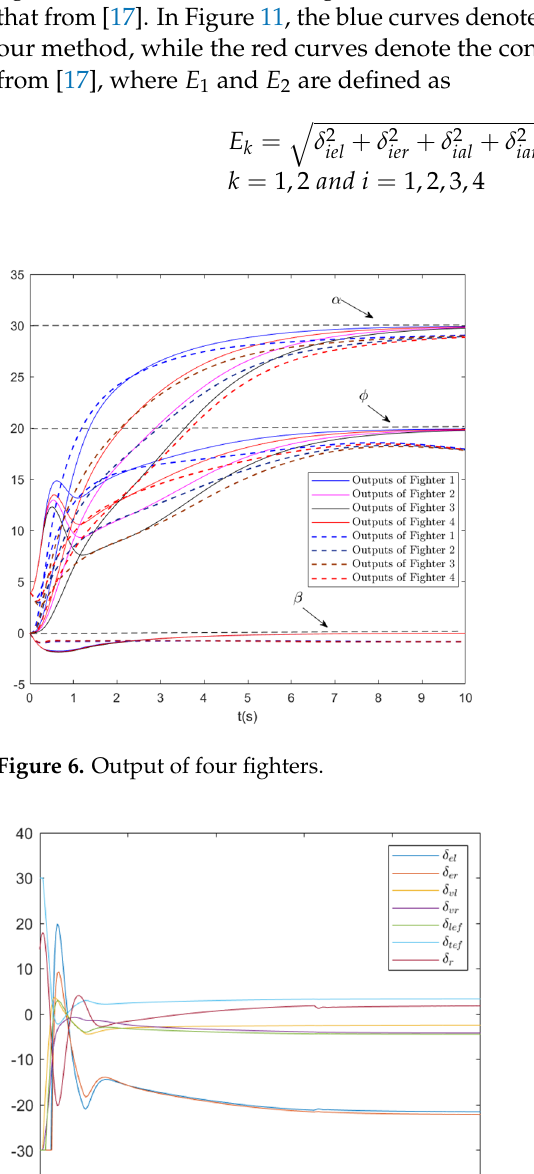
Figure 8. Actuator actions of Fighter 2.